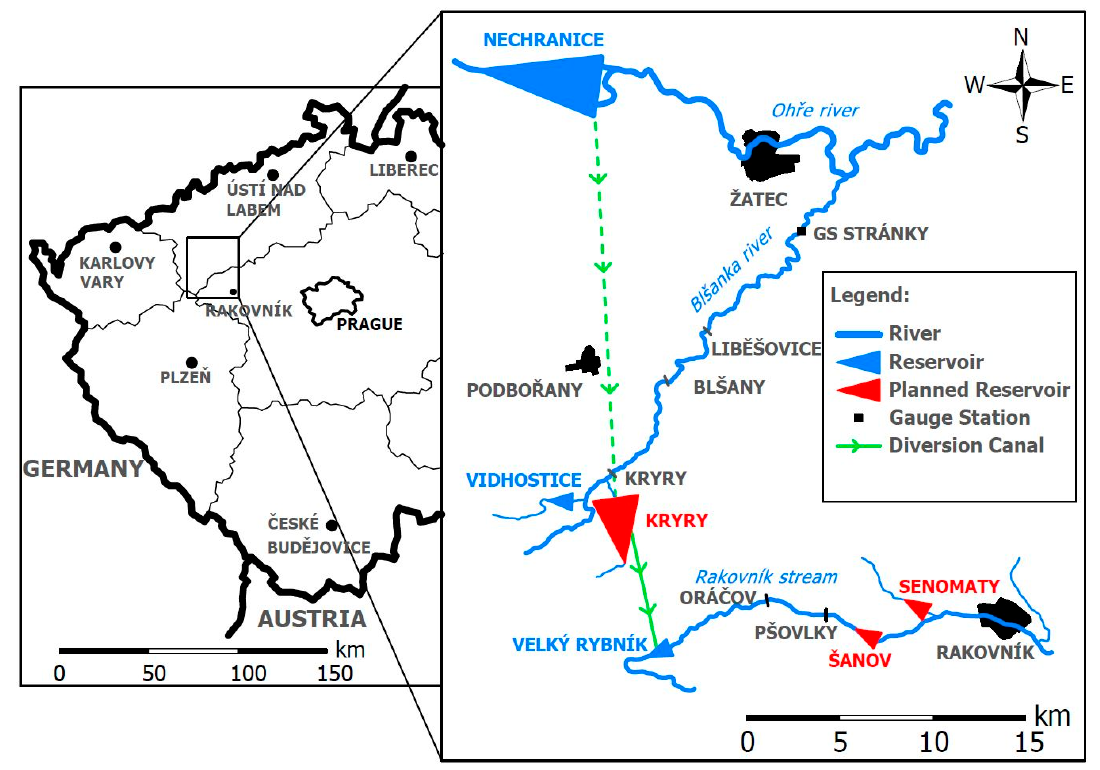
Figure 1. Map of the study area in the Czech Republic.